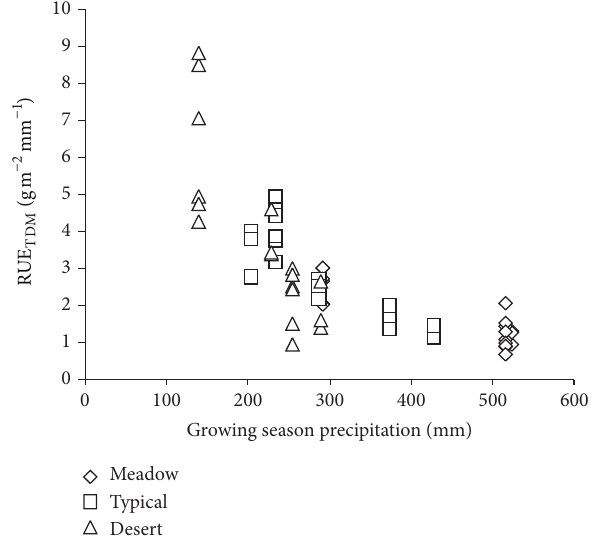
Figure 6: Relationship of RUE TDM (gm −2 mm −1 ) with growing season precipitation in meadow steppe, typical steppe, and desert steppe across the grassland of Inner Mongolia. RUE TDM = rain use efficiency based on total dry matter.